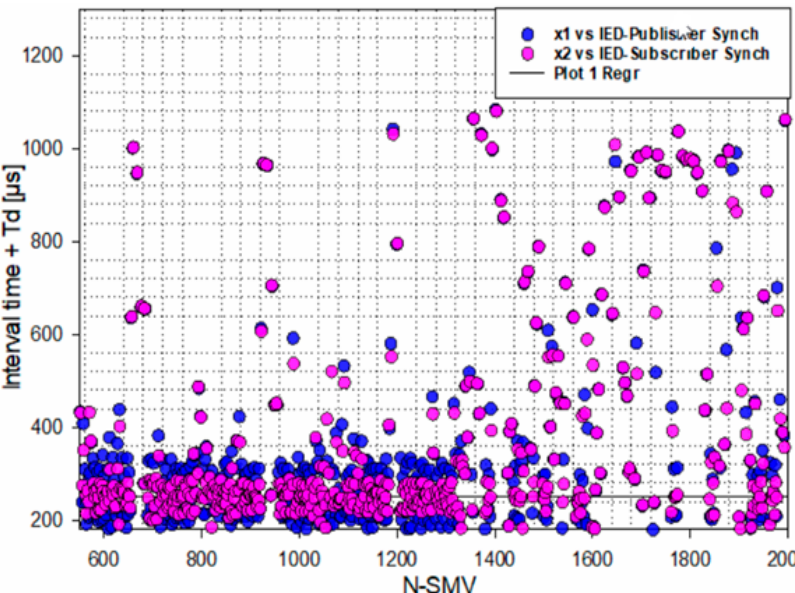
Figure 11. The interval time + delay time in µ sec between publisher / subscriber IEDs.